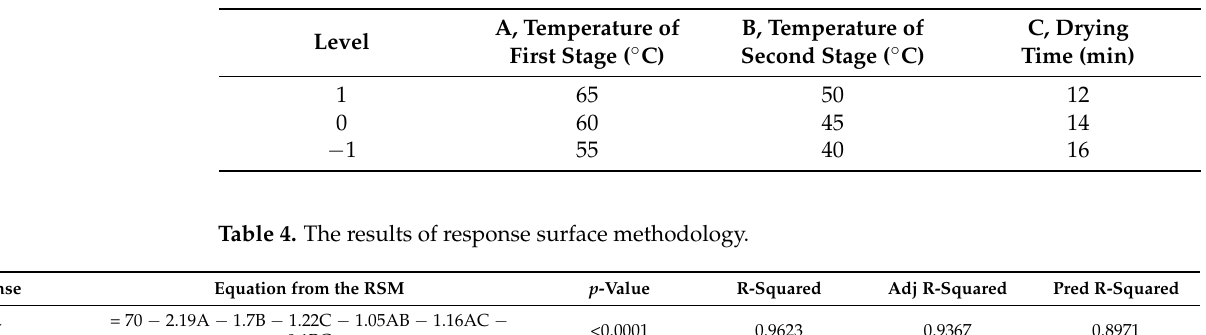
Figure 2. The single factor experiments results. ( a ) the head rice yield of the paddy rice in the first stage, the moisture content of rice samples was 23% ± 0.1%, ( b ) the head rice yield of the paddy rice in the second stage, the moisture content of rice samples was 18% ± 0.1%, ( c ) the head rice yield of the paddy rice at different drying time. Table 3. Factors and their coded and actual levels used in response surface methodology.